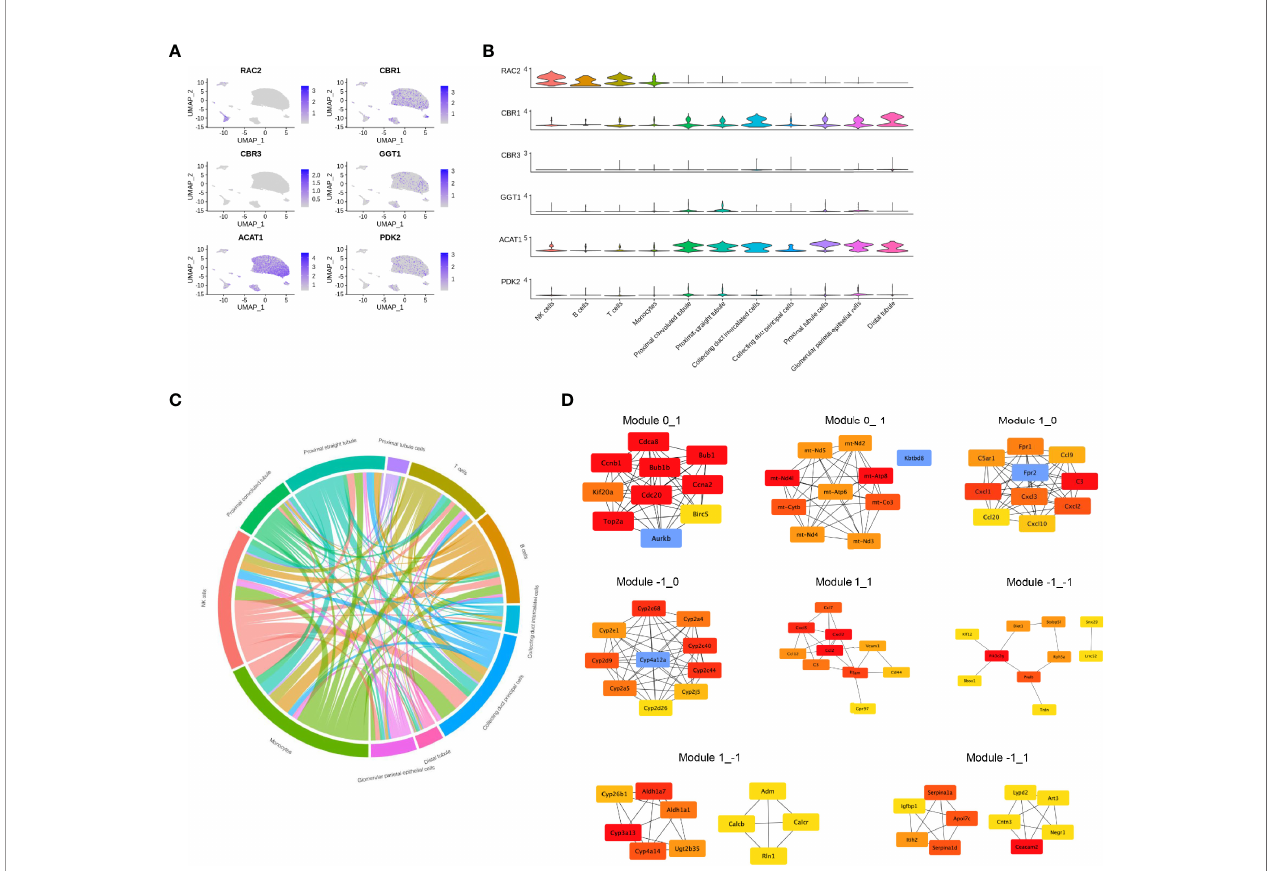
FIGURE 5 | Gene expression pro fi le in each cell type. (A) The normalized expression of each gene in the human kidney. (B) Violin plot showing the gene expression in each cell type. (C) Cell-and-cell interaction between different clusters. (D) Protein-and-protein interaction network of different